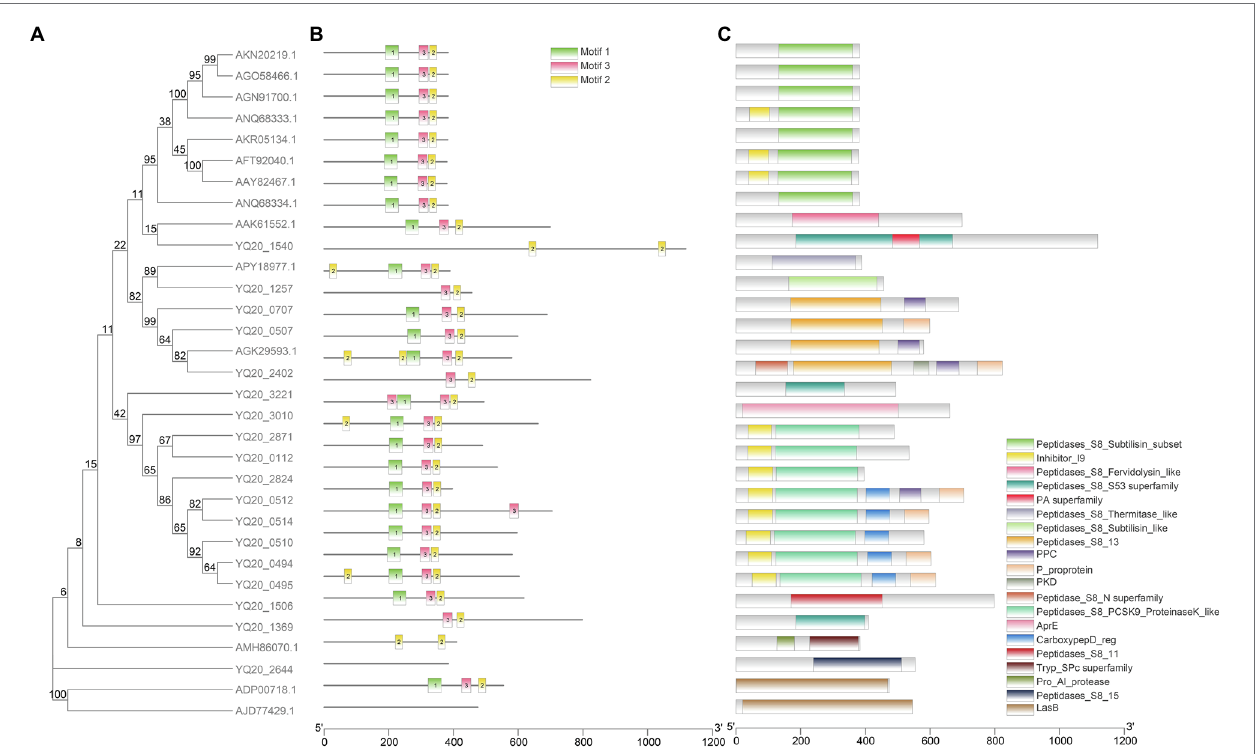
FIGURE 6 | Phylogenetic relationships, conserved protein motifs, and conserved domains of known keratinase and proteins from Lysobacter brunescens YQ20 by Blastp. (A) Phylogenetic tree. The phylogenetic tree was constructed using the Maximum Likelihood method with 500 bootstrap replications and a WAG model. Keratinases from Bacillus are colored in green. (B) Motif composition of all proteins. The motifs are displayed in different colored boxes. (C) Conserved domain analysis by NCBI CDD. The protein length can be estimated using the scale bar at the